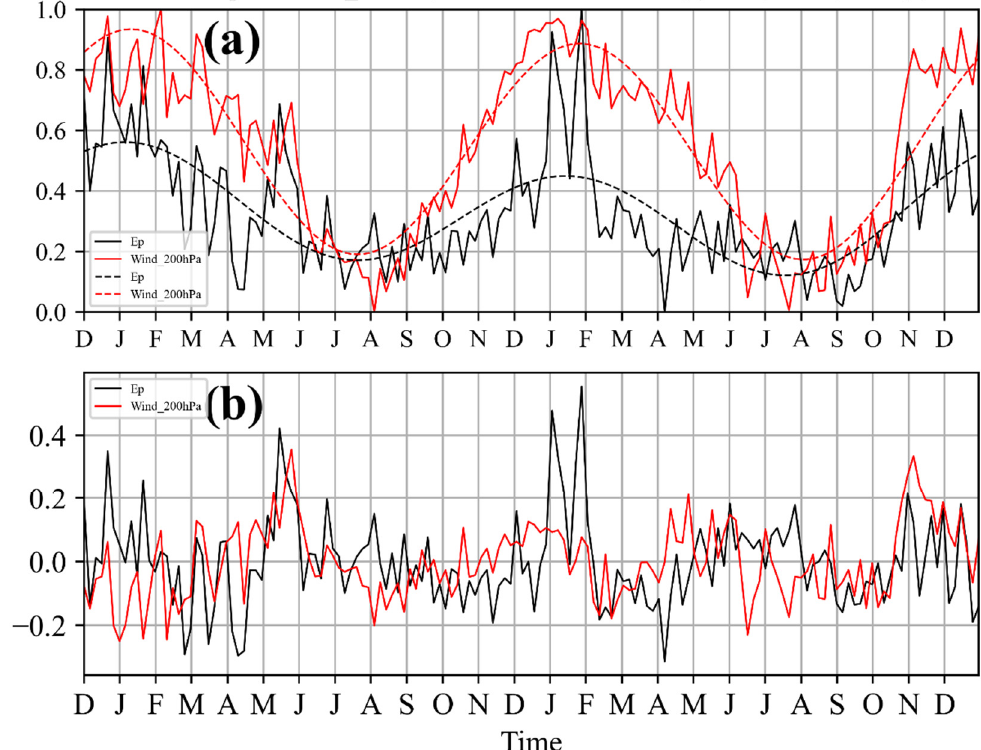
Figure 9. ( a ) Normalized time series of Ep at 20 km (black solid line), normalized time series of wind speed at 200 hPa (red solid line), the seasonal variations of Ep at 20 km (black dashed line) and wind speed at 200 hPa (red dashed line). ( b ) The shorter time scale variations of Ep (black line) and wind speed (red line) in box A.